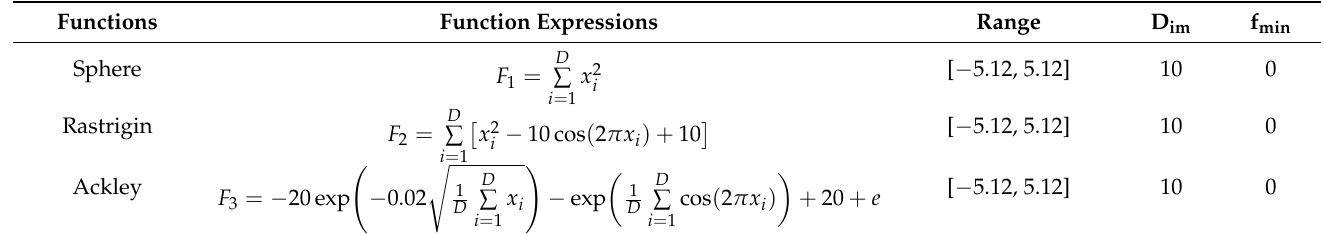
Table 1. Description of benchmark functions.